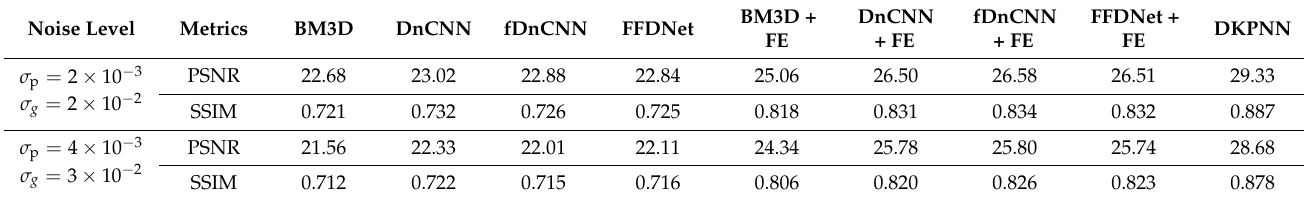
Figure 9. Spectral sensitivity function of LCTF-ICMOS: ( a ) spectral transmittance function of LCTF; ( b ) spectral sensitivity function of image intensifier; ( c ) relative response function of LCTF and image intensifier.